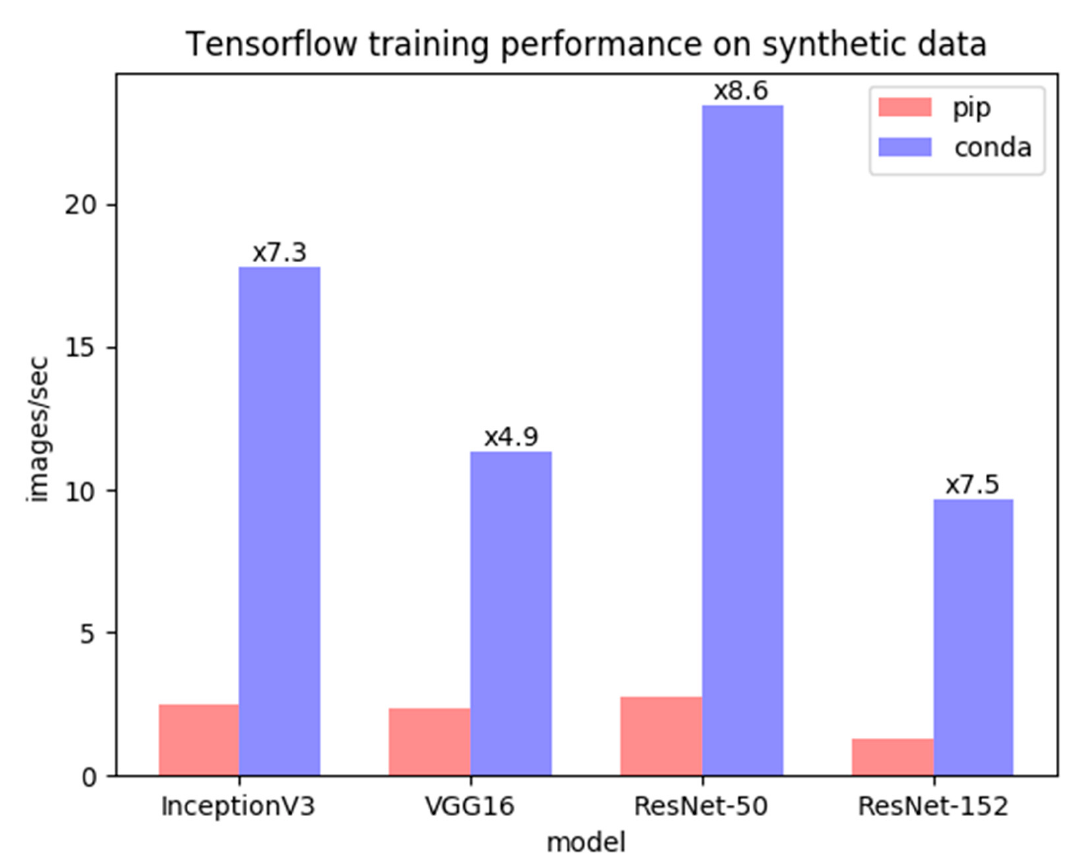
Figure 8. TensorFlow training performance with synthetic data [39].